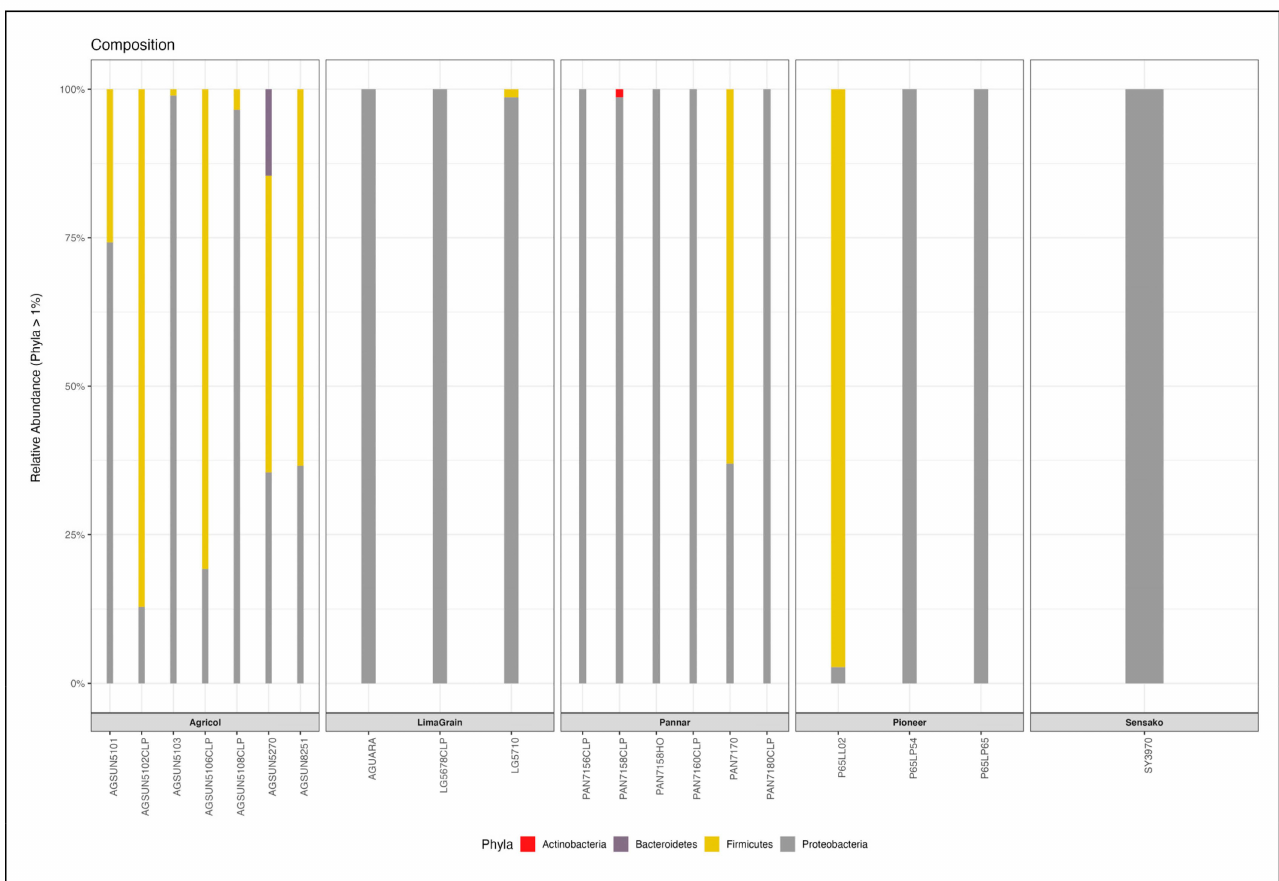
Figure 9. Relative abundance of the dominant bacteria Phyla from different cultivars of S. Africa H. annus